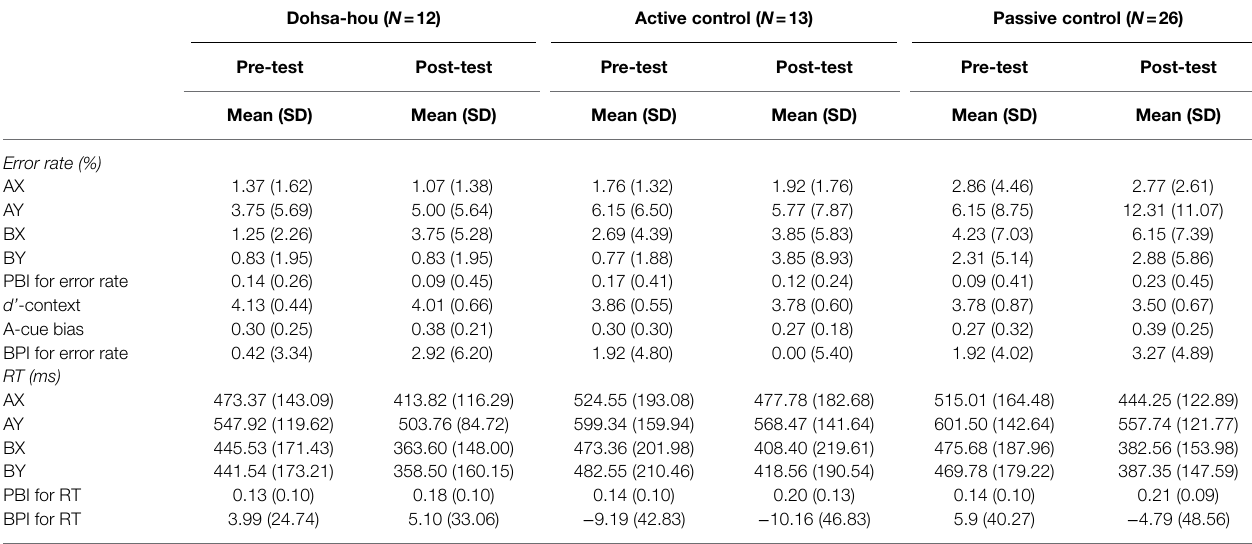
TABLE 1 | Descriptive statistics of AX-CPT for Dohsa-hou group, Active control group, and Passive control group measured at pre- and